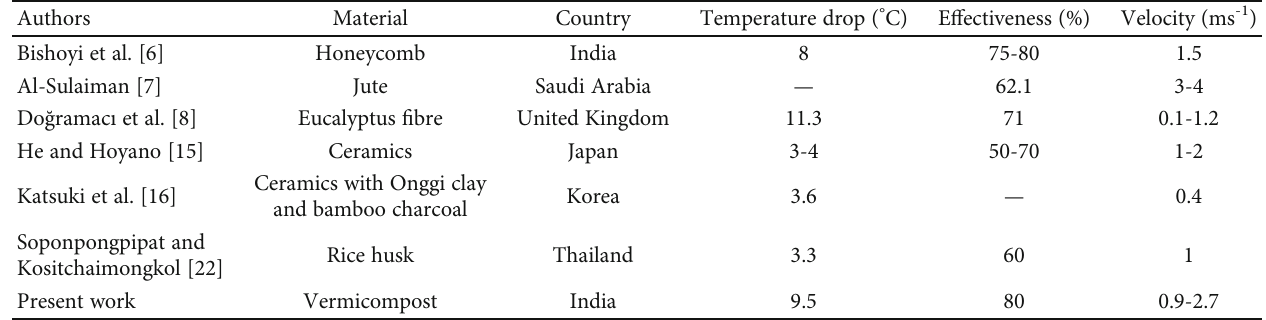
Table 4: Research outcomes of di ff erent pad materials in evaporative